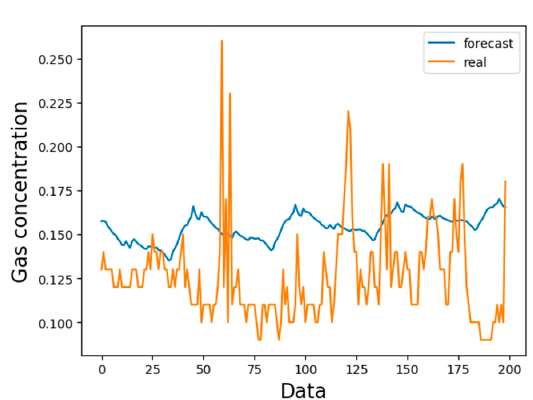
Figure 10. Comparison of predicted length loss.